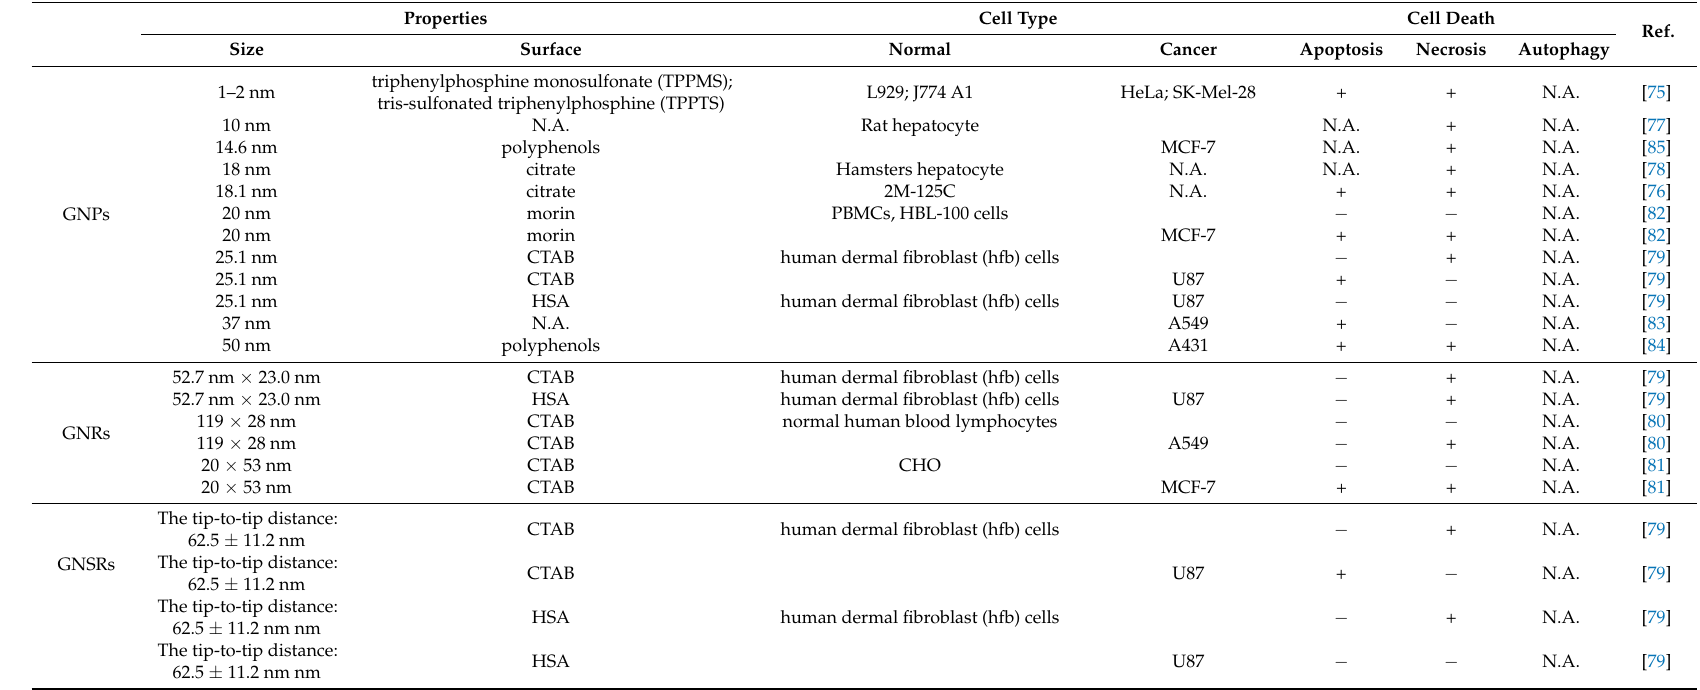
Table 2. The relationship between GNPs’ properties and